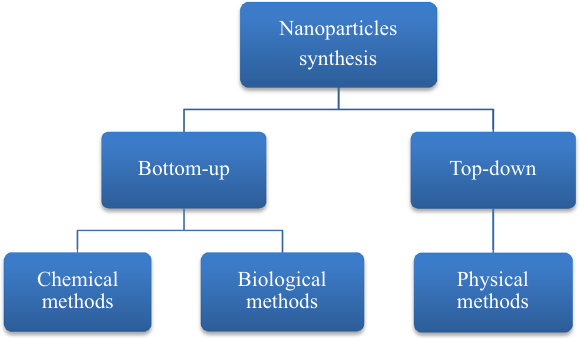
Figure 1: Nanoparticle synthesis methods ( bottom - up and top - down approaches )